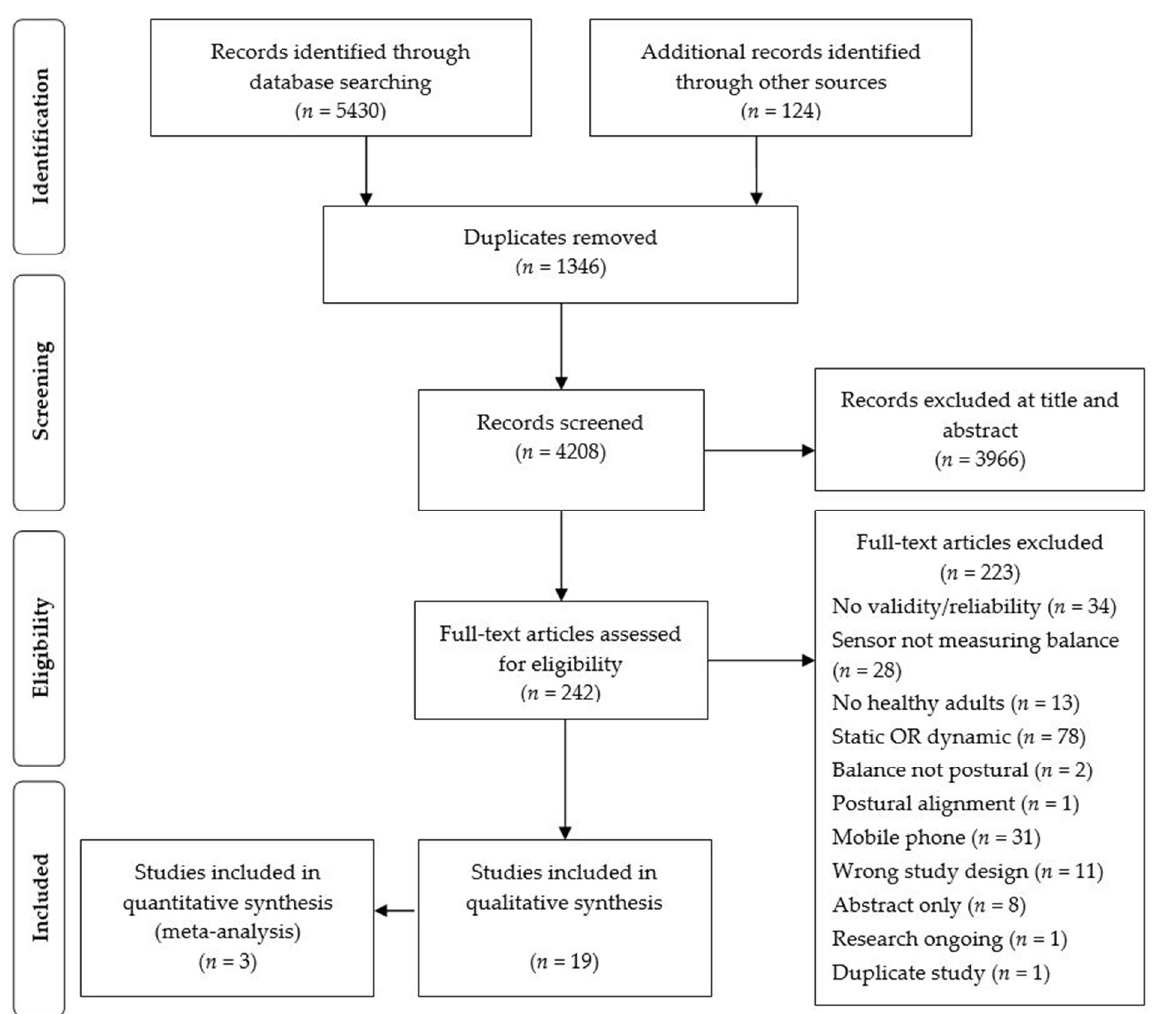
Figure 1. PRISMA flow diagram.